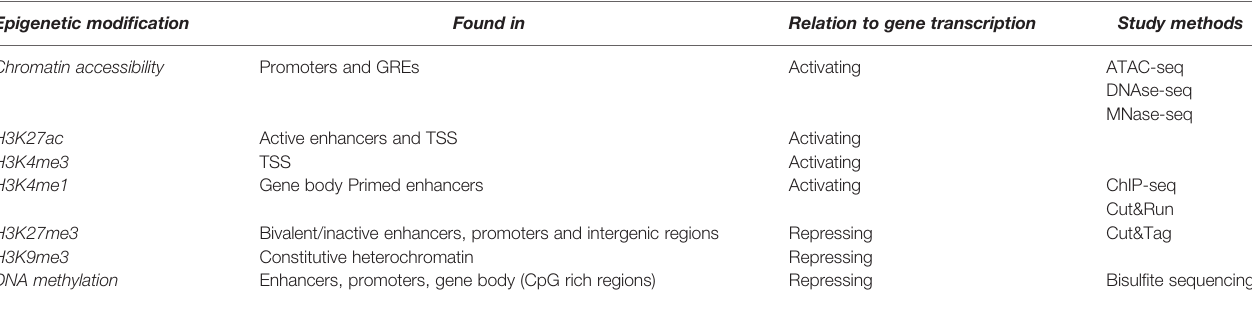
TABLE 2 | Summary of epigenetic modi fi cations and their effects on gene expression. Epigenetic modi fi cation Found